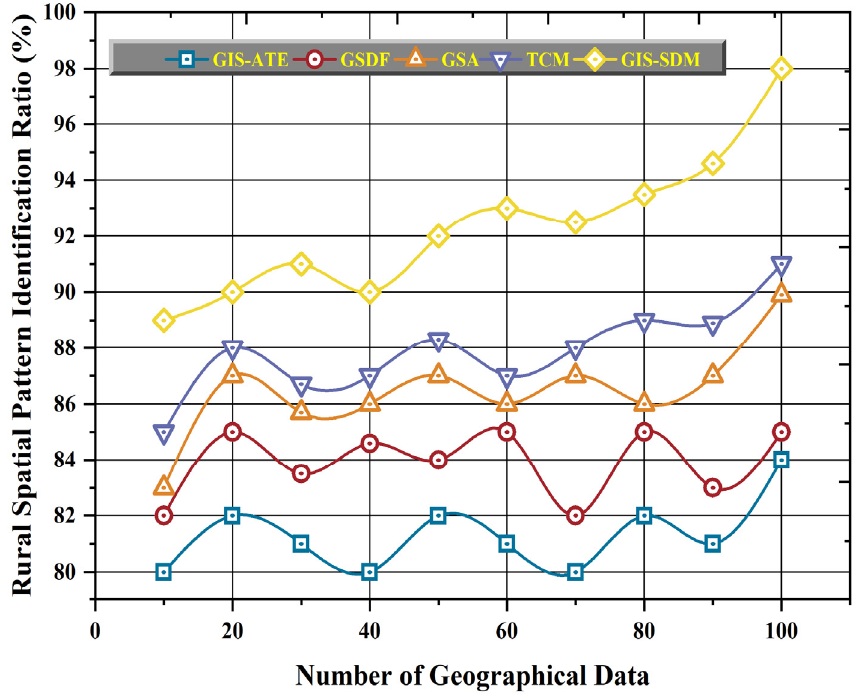
Figure 7. Rural spatial pattern identification ratio.